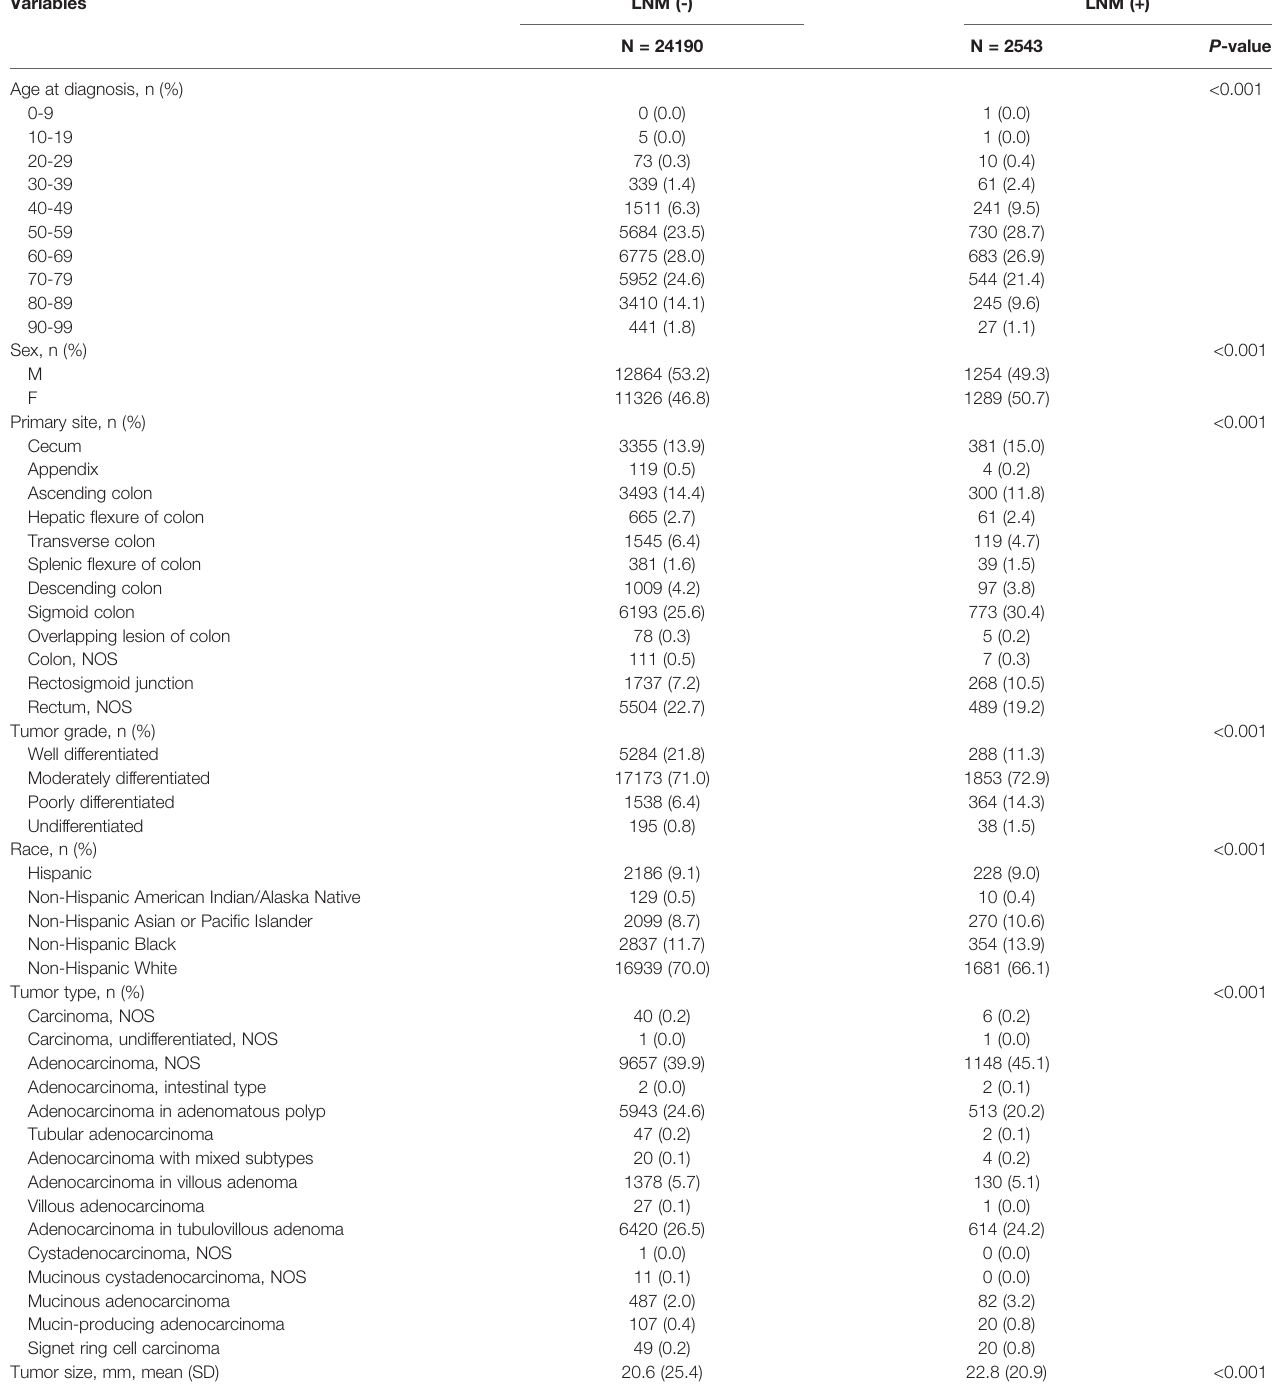
TABLE 1 | Baseline